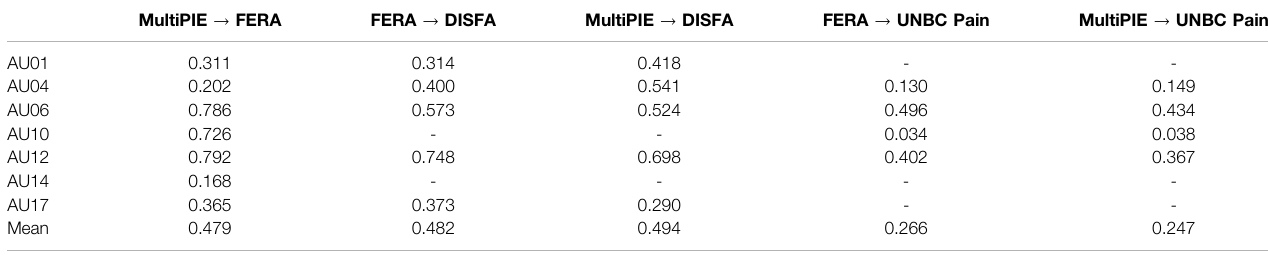
TABLE 5 | Cross domain ICC performance. (Synthetic training set → Real test set). MultiPIE → FERA